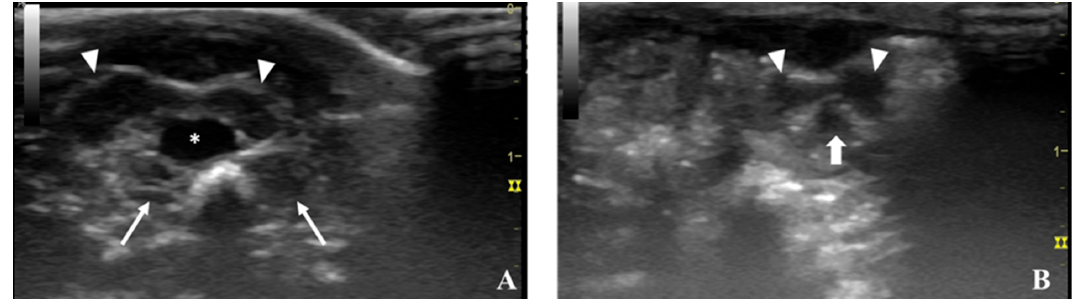
Figure 4. Transverse ultrasonographic scan of the prostate from control animals. The scan was performed in the caudal aspect of the abdomen ( A ) and in the inguinal region ( B ). In A can be observed the urinary bladder (asterisk) surrounded by the ventral lobes of the prostate (arrowheads) and the seminal vesicles (arrows), and in B , the neck of the urinary bladder surrounded by the ventral prostate lobes (arrowheads) and the dorsal prostate lobe (bold arrow). The 1 represents the depth (1 cm). The yellow II represents the focus of the ultrasound beam.